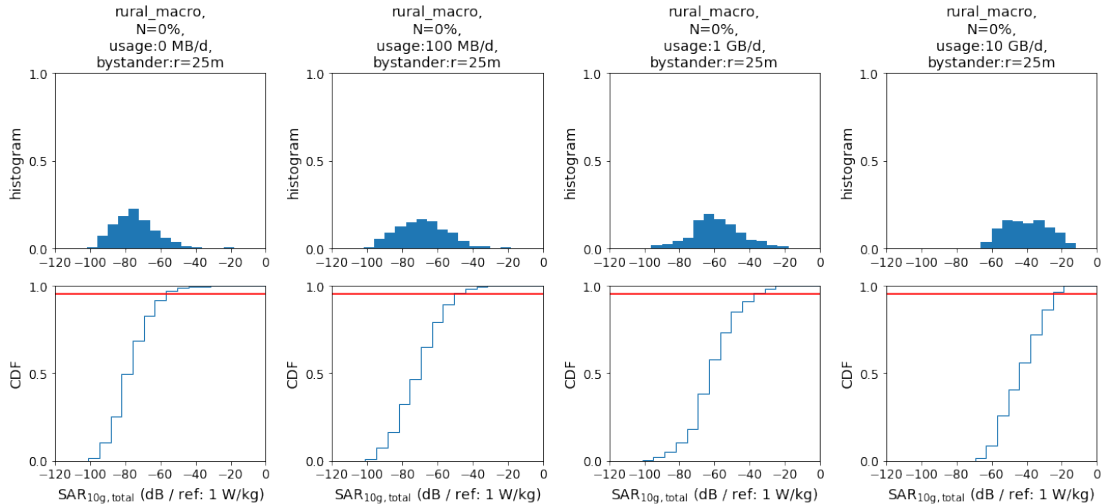
Figure 3. Histograms and cumulative distribution functions for the rural cell scenario as a function of usage (increasing left to right), with constant network topology. Statistic summaries of all simulated scenarios are presented in the Appendix